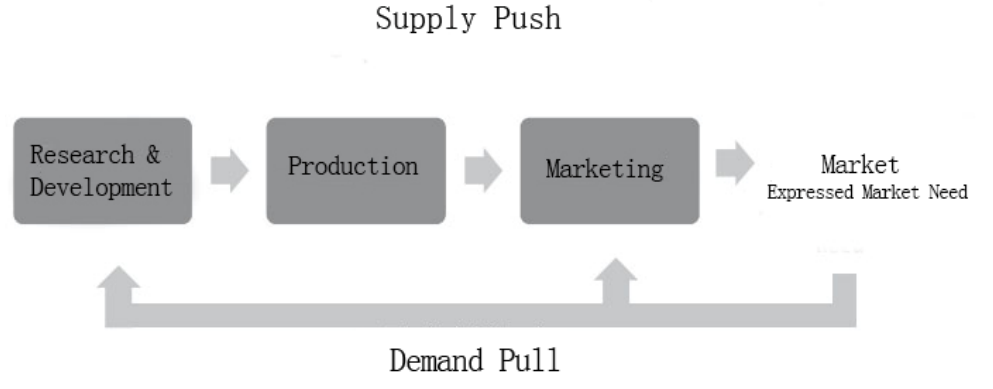
Figure 2. Matching supply-push with demand-pull forces.